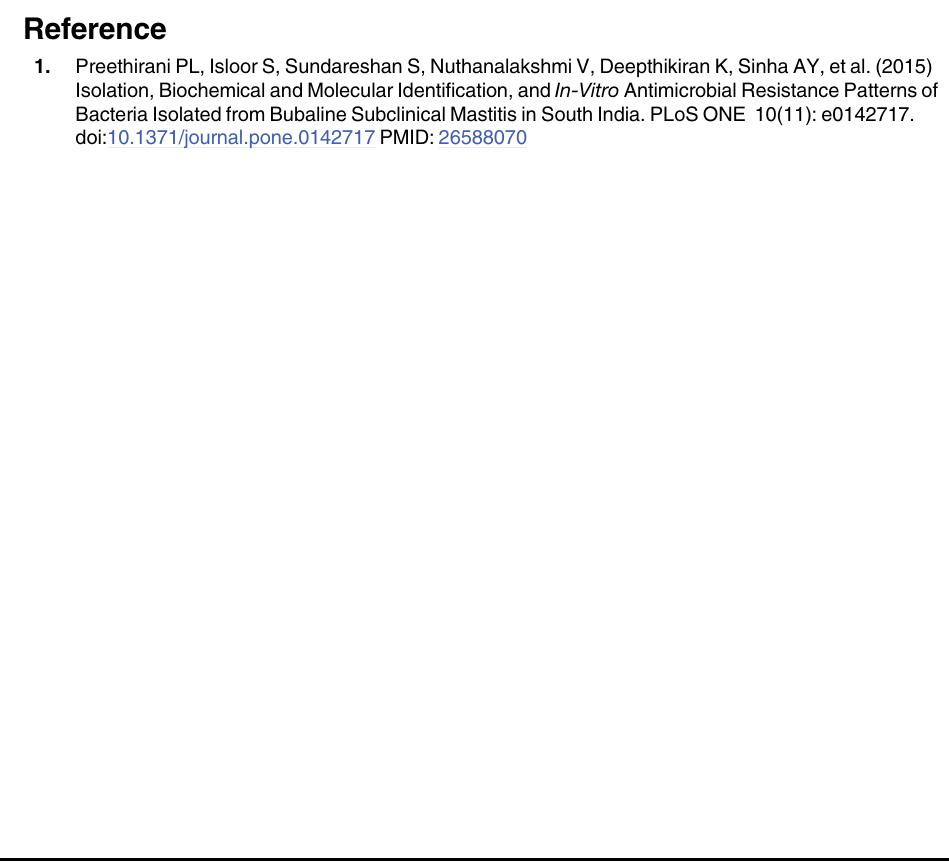
S1 Fig. Corrected Fig